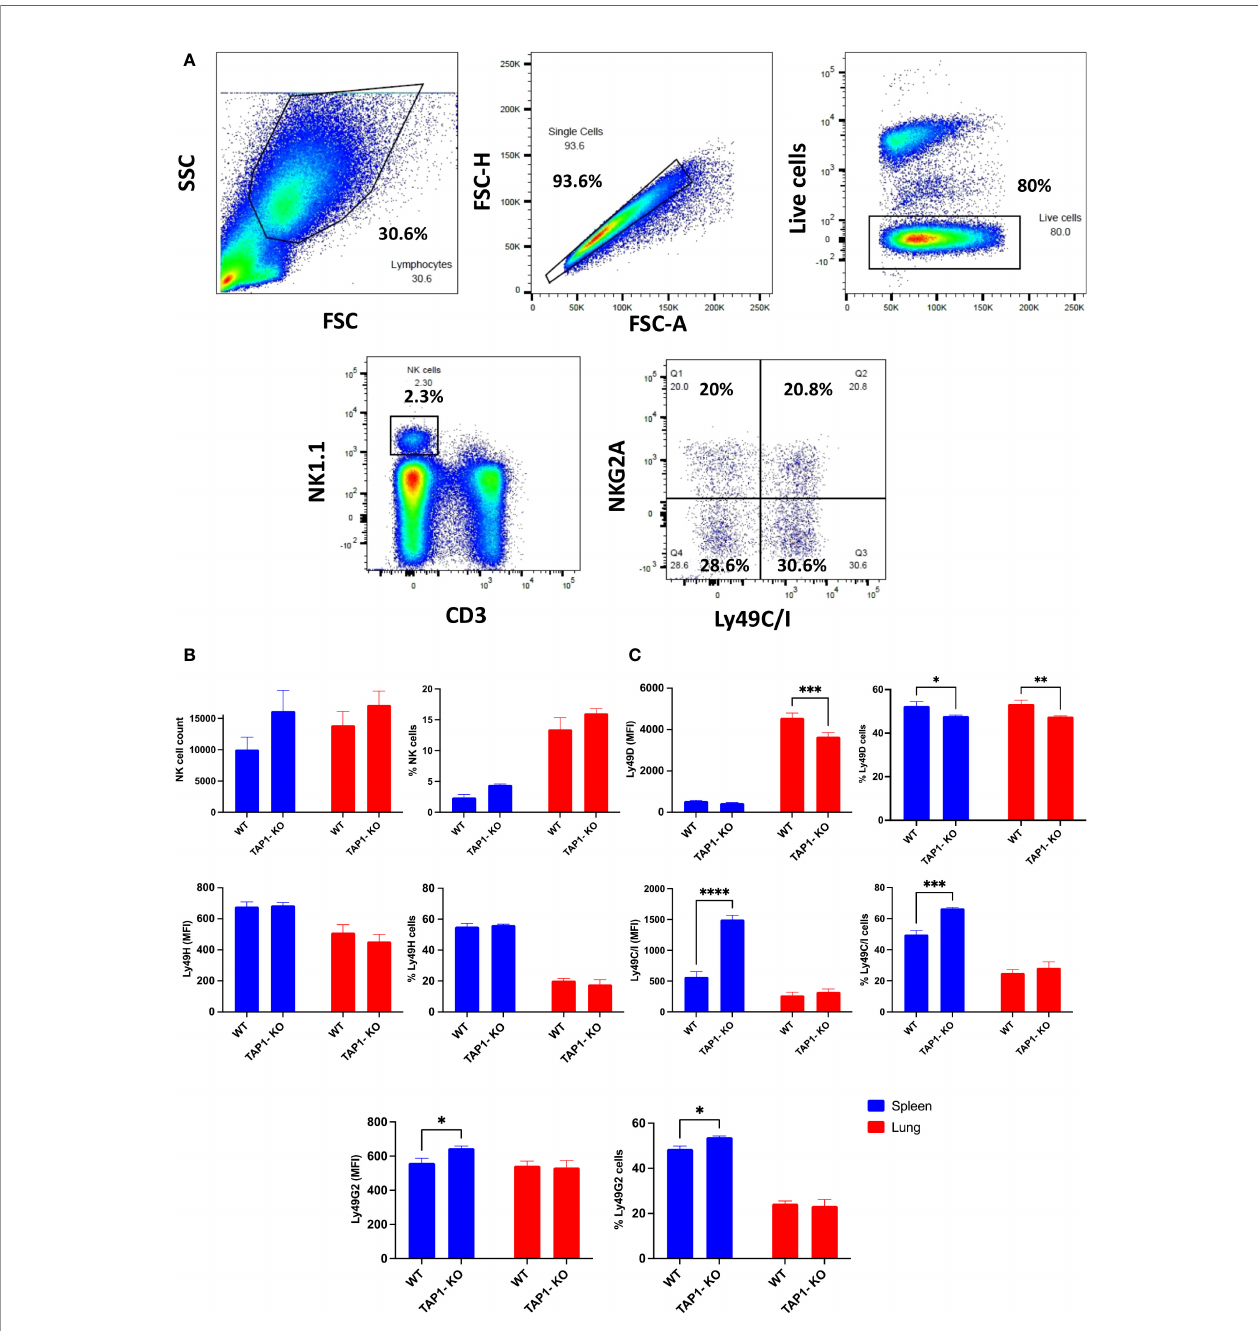
FIGURE 1 | Comparison of NK cells from B6 and TAP1-KO littermates in spleen and in lung. (A) Gating strategy used to identify murine NK cells and their subsets. Representative fl ow cytometry plots of NK cells derived from mouse lung/spleen gated using the side and forward scatter dot plot display. NK cells were de fi ned as CD3-NK1.1+ events and were further divided into NK cell subsets based on the expression levels of NKG2A and Ly49C/I. (B) Comparison of NK cell absolute count and frequency in live cells between wildtype B6 and TAP1-KO littermates derived from lung and spleen. (C) The comparison of some activating (Ly49D, Ly49H) and inhibitory (Ly49C/I, Ly49G2) members of the Ly49 family in spleen and in lung. Statistical analyses were performed using GraphPad Prism 9.0.0 with an ordinary two-way ANOVA with Sidak multiple comparisons tests (n=3). *, p<0.05, **, p<0.01, ***, p<0.001 and ****,